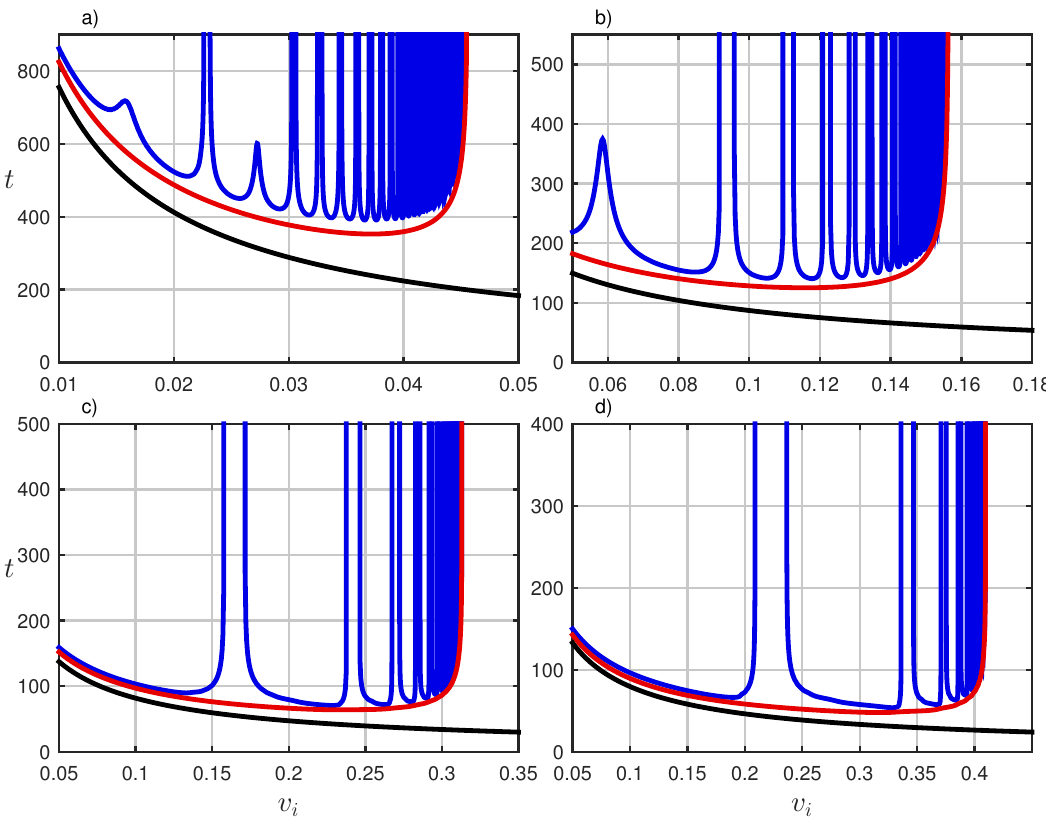
Figure 13 . Φ 2+ ( x ) antikink scattering with φ 1 boundary: time of the first (black), second (red) and third (blue) bounce versus initial velocity for (a) H = 0, (b) H = 0 . 2 H m , (c) H = 0 . 4 H m , and (d) H = 0 . 5 H m